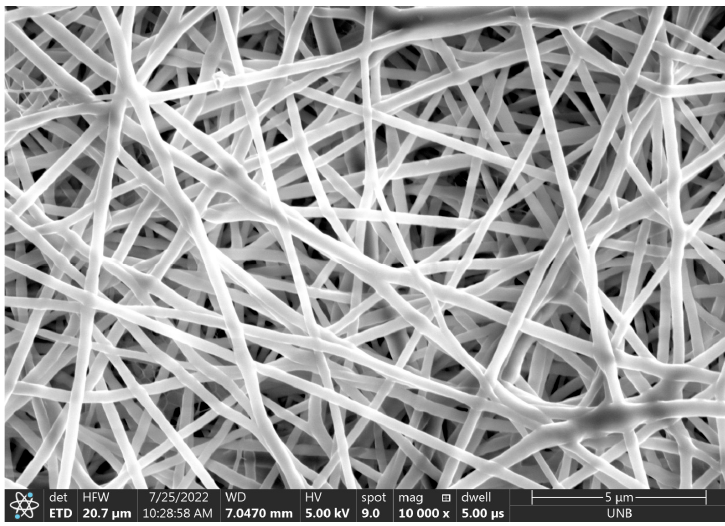
Figure 8. The 10,000x magnification of electrospun fibers from deposit 1.